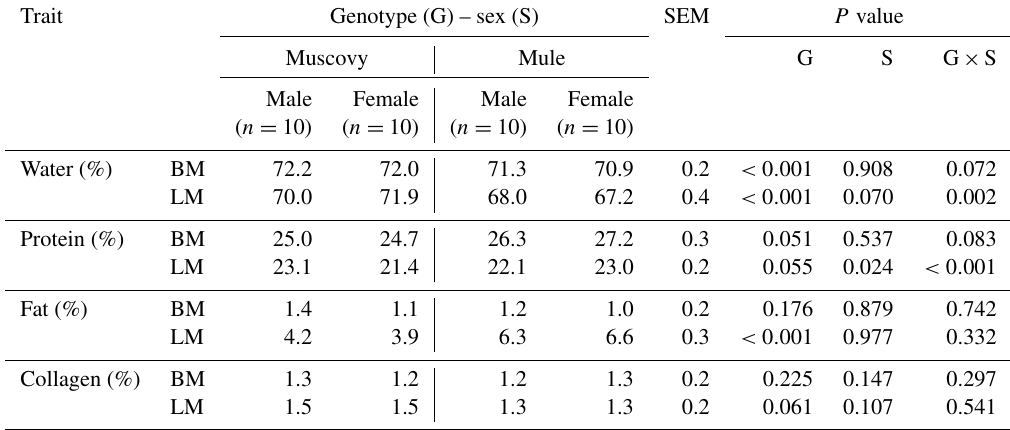
Table 2. Basic chemical composition of the breast and leg muscles of ducks of different genotypes. Trait